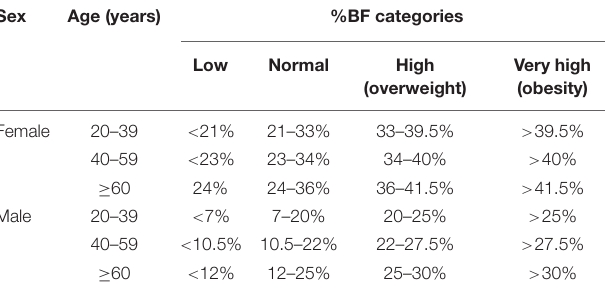
TABLE 1 | Age and sex adjuster cut-off values for body fat percentage (%BF) categories.